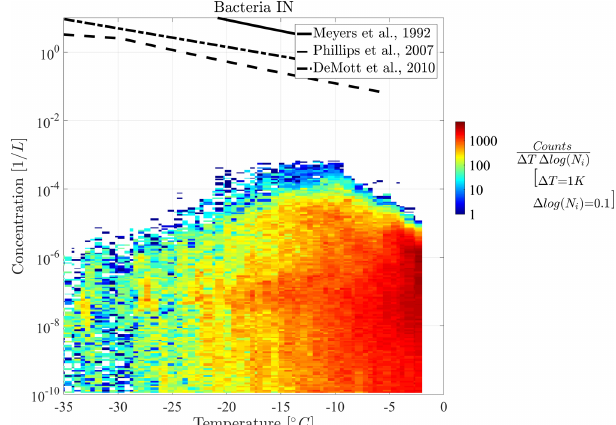
Figure 6. Two-dimensional histogram of concentration vs. temper- ature for both fungal spore